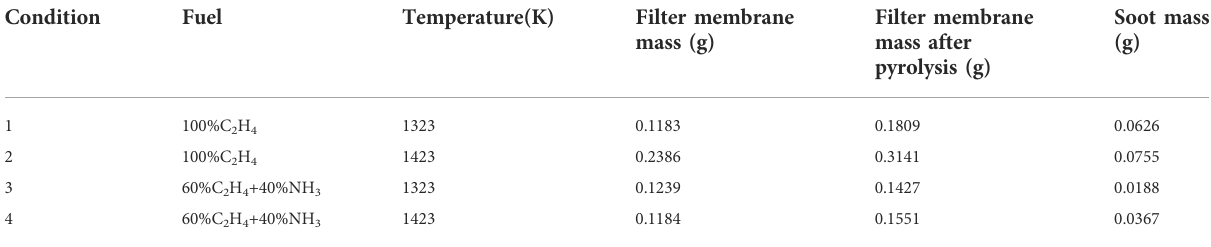
TABLE 2 Yield of soot under different conditions.